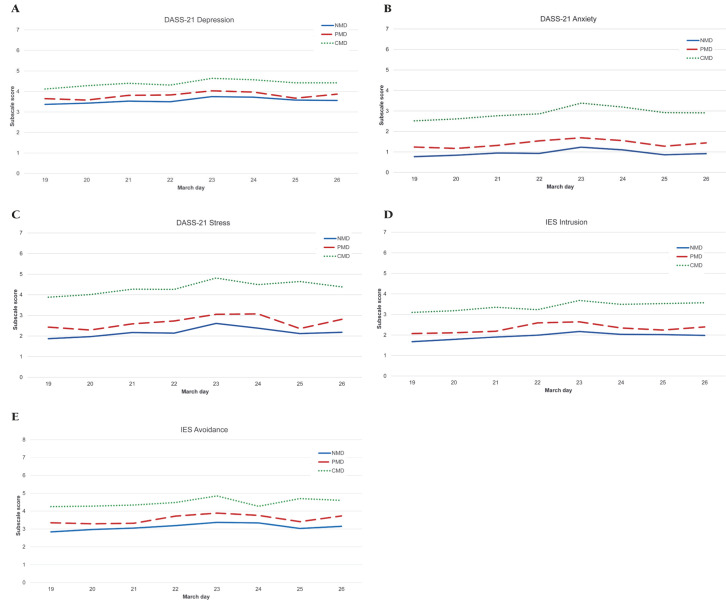
Psychological impact according to the number of days elapsed between the declaration of the state of alarm and the confinement in Spain (March 14) and the response to our questionnaire (March 19 – March 26) for the three mental state groups. Panel A. Depression, Anxiety and Stress subscale scores. Blue solid line: Never mental disorder (NMD); red dashed line: Past mental disorder (PMD); green dotted line: Current mental disorder (CMD). Panel A Depression. DASS-21: Depression, Anxiety and Stress Scale, NMD: Never mental disorder, PMD: Past mental disorder, CMD: Current mental NMD: F = 26.642, P < 0.001; PMD: F = 10.010, P < 0.001; CMD: F = 6.187, P < 0.001. Panel A Anxiety. DASS-21: Depression, Anxiety and Stress Scale, NMD: Never mental disorder, PMD: Past mental disorder, CMD: Current mental. NMD: F = 18.206, P < 0.001; PMD: F = 4.933, P < 0.001; CMD: F = 5.877, P < 0.001. Panel A Stress. DASS-21: Depression, Anxiety and Stress Scale, NMD: Never mental disorder, PMD: Past mental disorder, CMD: Current mental. NMD: F = 18.313, P < 0.001; PMD: F = 6.006, P < 0.001; CMD: F = 6.151, P < 0.001. Panel B. Impact of Event subscale scores. Blue solid line: Never mental disorder (NMD); red dashed line: Past mental disorder (PMD); green dotted line: Current mental disorder (CMD). Panel B Intrusion. IES: Impact of Event Scale, NMD: Never mental disorder, PMD: Past mental disorder, CMD: Current mental. NMD: F = 16.566, P < 0.001; PMD: F = 5.332, P < 0.001; CMD: F = 3.660, P = 0.001. Panel B Avoidance. IES: Impact of Event Scale, NMD: Never mental disorder, PMD: Past mental disorder, CMD: Current mental. NMD: F = 16.566, P < 0.001; PMD: F = 5.332, P < 0.001; CMD: F = 3.660, P = 0.001.